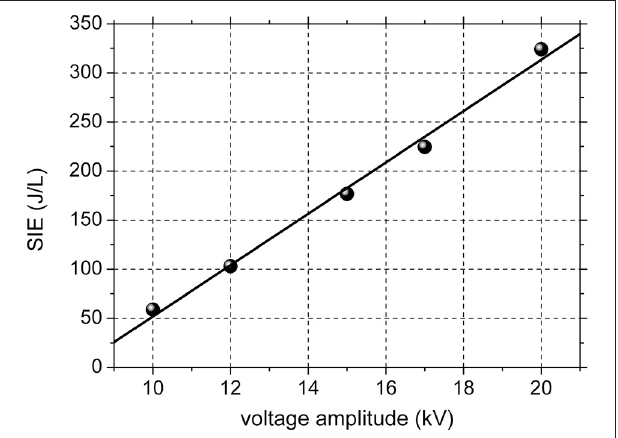
FIGURE 1 | Specific input energy as a function of amplitude of the discharge